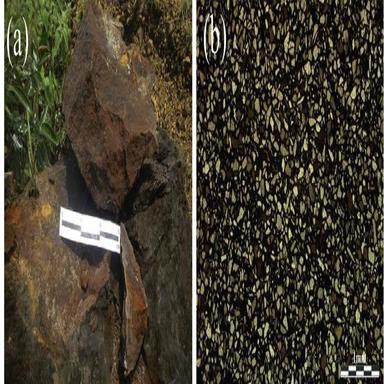
X-ray diffraction (XRD) pattern of the FSS in the Vicente locality near the Pedreira River (sample RP.R.03/14), in which the domain quartz, goethite, and restricted hematite are identified.